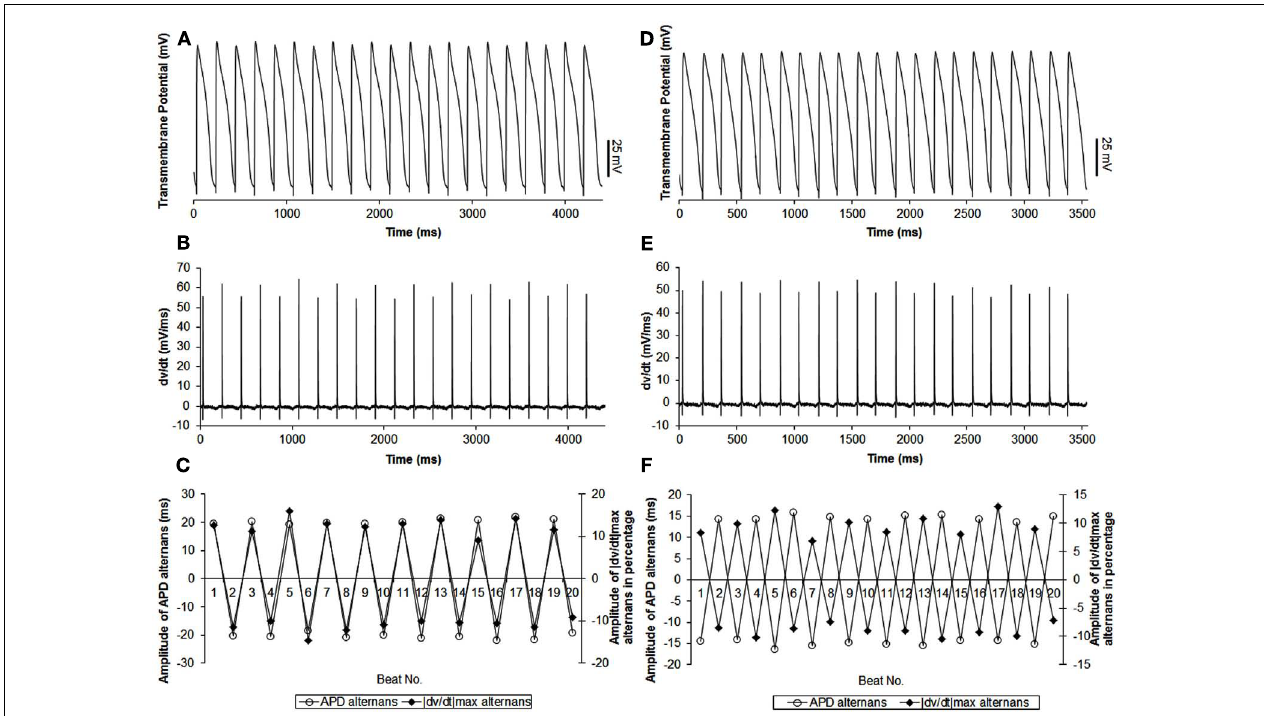
FIGURE 3 | Example of continuous recordings, during constant CL pacing, showing in phase (A–C) and out of phase (D–F) relationship betweenAPD and |d v /d t | max alternans in canines. Both APD (A,D) and |d v /d t | max (B,E) traces display beat-to-beat alternating patterns. (C,F) Show